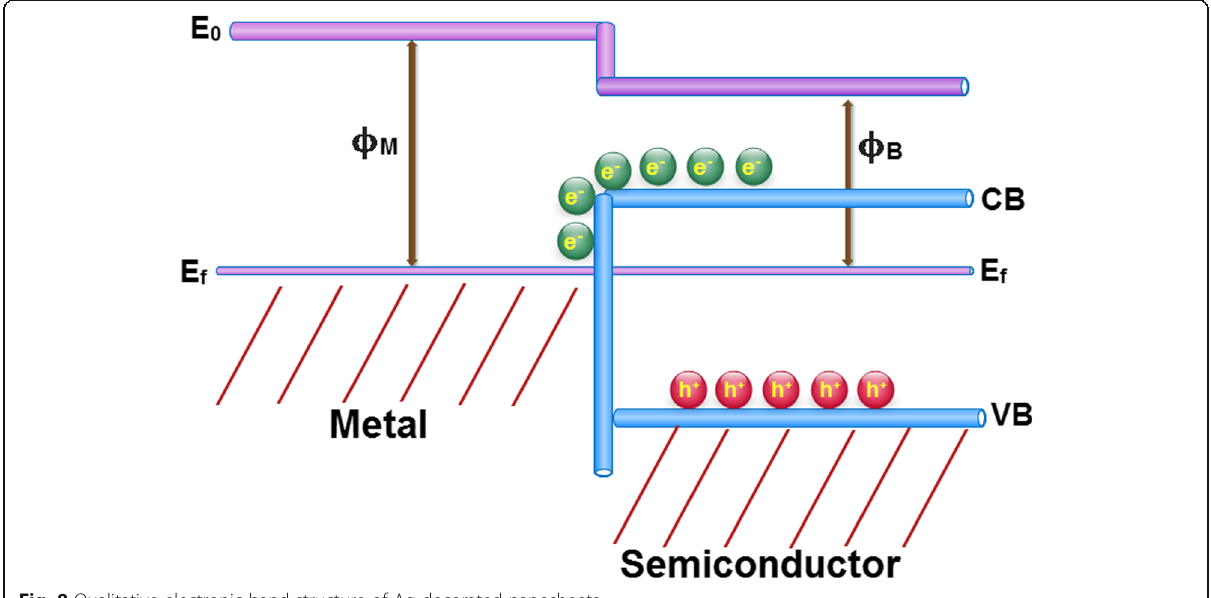
Fig. 8 Qualitative electronic band structure of Ag decorated nanosheets